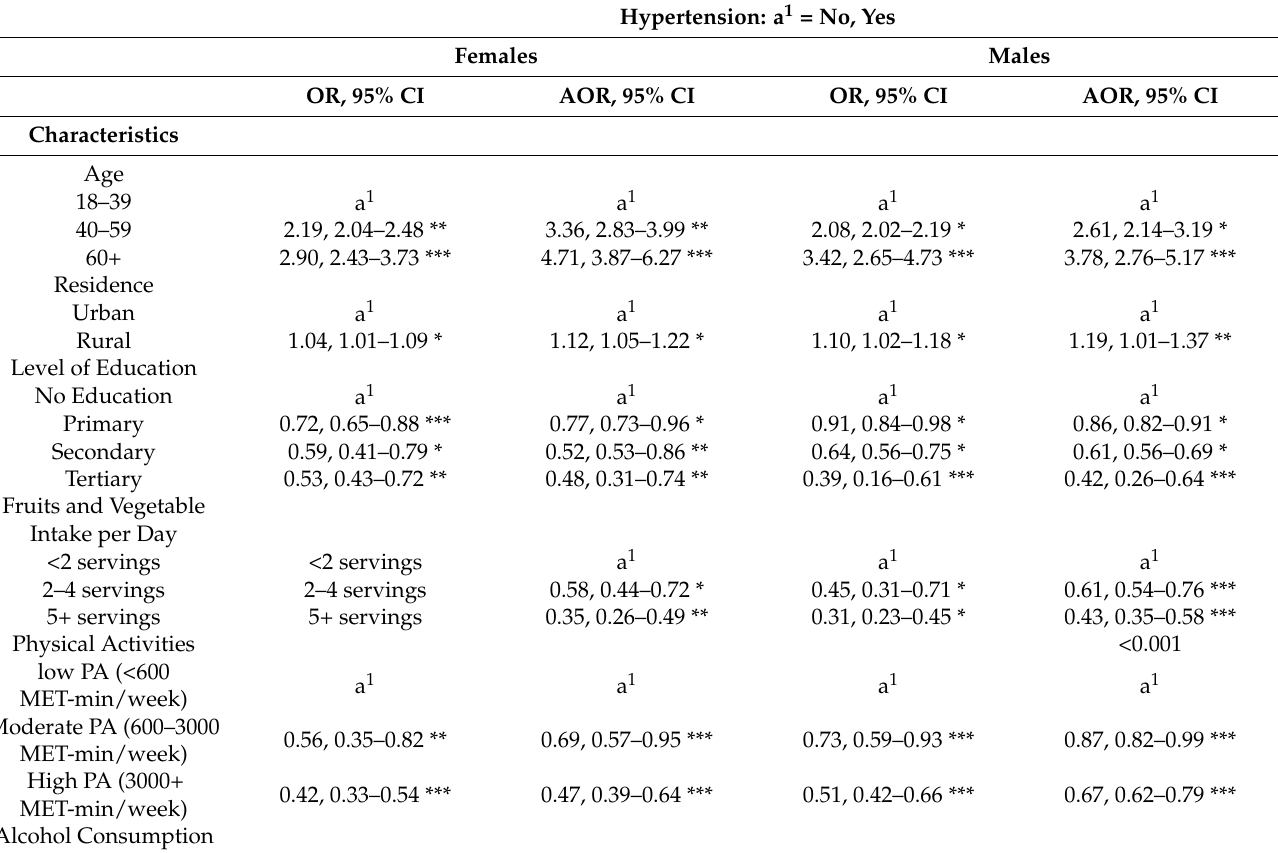
Table 3. Anthropometric, Sociodemographic and Behavioural Factors Associated with Hypertension among Males and Females in